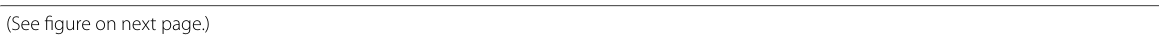
figure on next Fig. 9 Examples of scanpaths obtained from the artificial foveation data. The top panel shows a trial from the Random Order, No Color condition and the bottom panel shows a trial from the Numerical Order, Color Coding condition. The first and last regions viewed are marked with red and black stars, respectively. The first visit to each region is indicated with a red box and the second visit is indicated with a yellow box. The box border is thicker when the dwell time in that region was more than 1